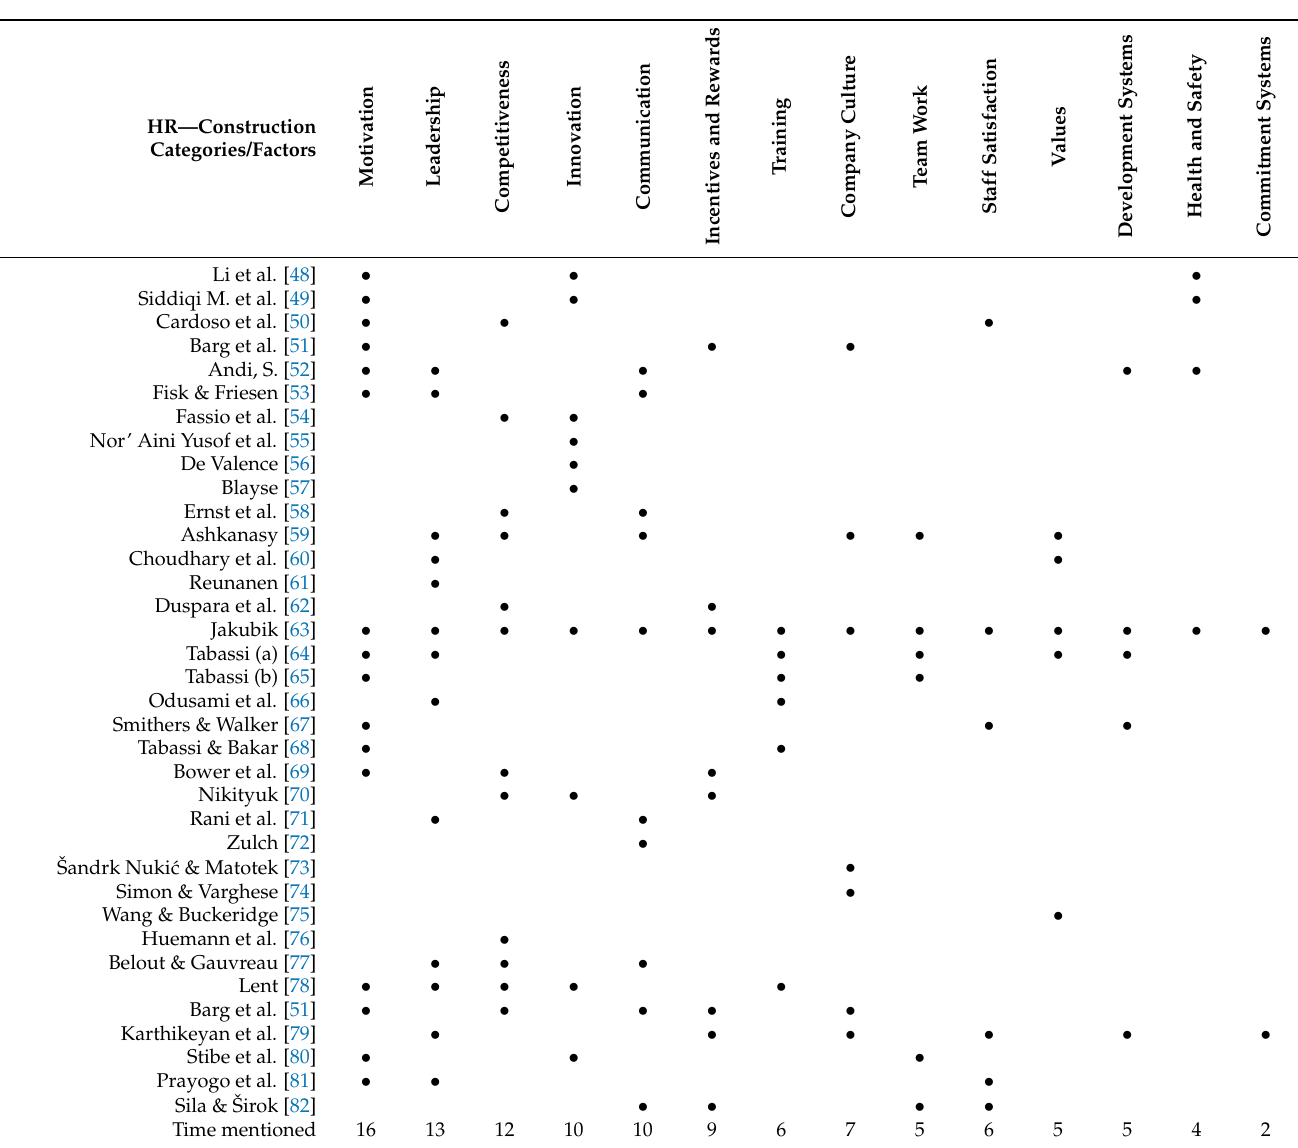
Table 3. The concept of HR in the Construction